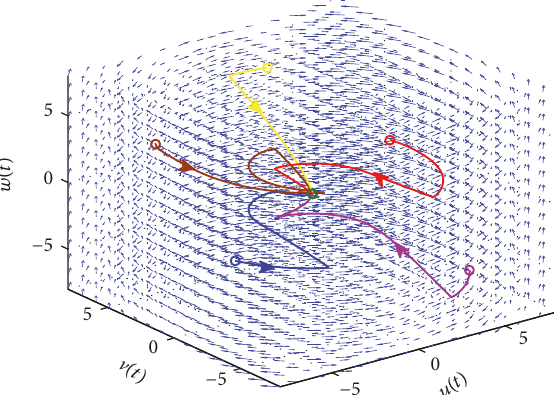
Figure 5: Behaviors of the coaxial counter rotating helicopter dynamical system (59) in 𝑢(𝑡) − V (𝑡) − 𝑤(𝑡) plane, which shows the behaviors of system (59) with control input for the initial points of (−6, −2,−2) , (−6,4, 4) , (2, 6,6) , (6,−4, −6) , and (6, 2,1)